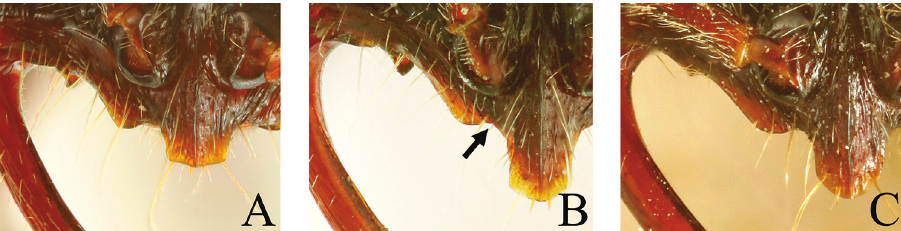
Figure 18. Clypeus, full-face view. A L . malayana B L. itoi C L. modiglianii